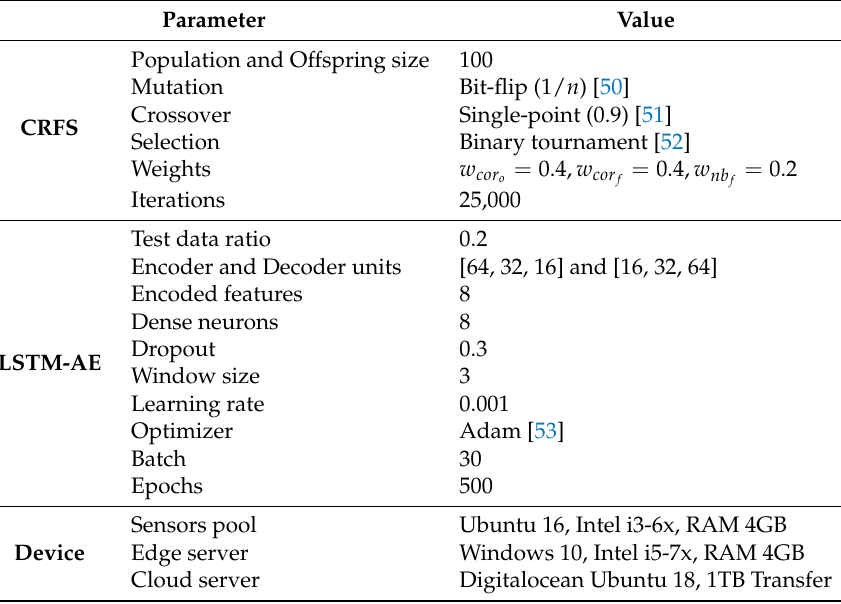
Table 4. Experimental